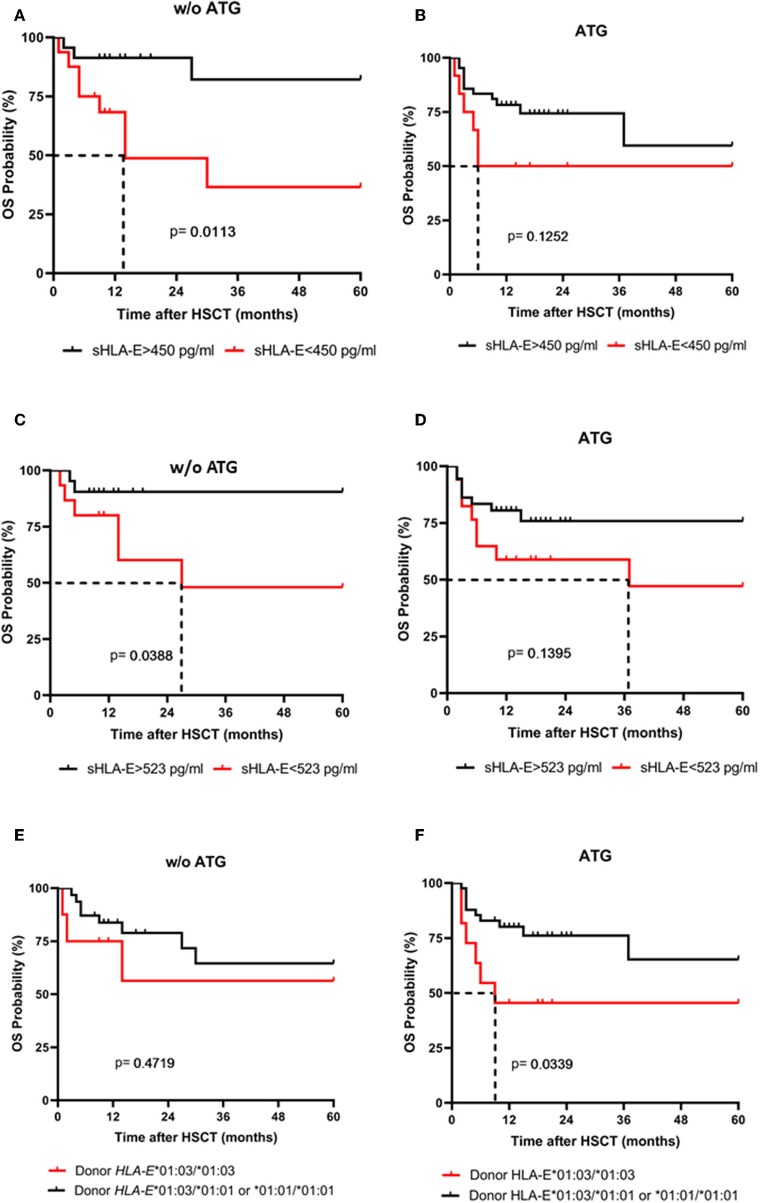
The impact of ATG conditioning on the association sHLA-E levels and donor HLA-E genotype with 5-year OS probability. 5-years OS probabilities were analyzed by Kaplan-Meier analysis combined with log-rank test in patients without (w/o) ATG (A,C,E) and with ATG treatment (B,D,F) concerning the sHLA-E cut-off levels obtained 1 (A,B) and 2 month(s) (C,D) post-HSCT and concerning the donor HLA-E genotype status (E,F). Dashed lines indicate the median survival of patients post-HSCT. Only in patients without (w/o) ATG treatment (A,C) a significantly lower 5-year probability was evident for patients with sHLA-E levels below the thresholds (A,C). Contrary to sHLA-E threshold levels, a significantly reduced 5-year OS probability was only found for ATG-treated patients receiving a HLA-E*01:03/01:03 allograft.